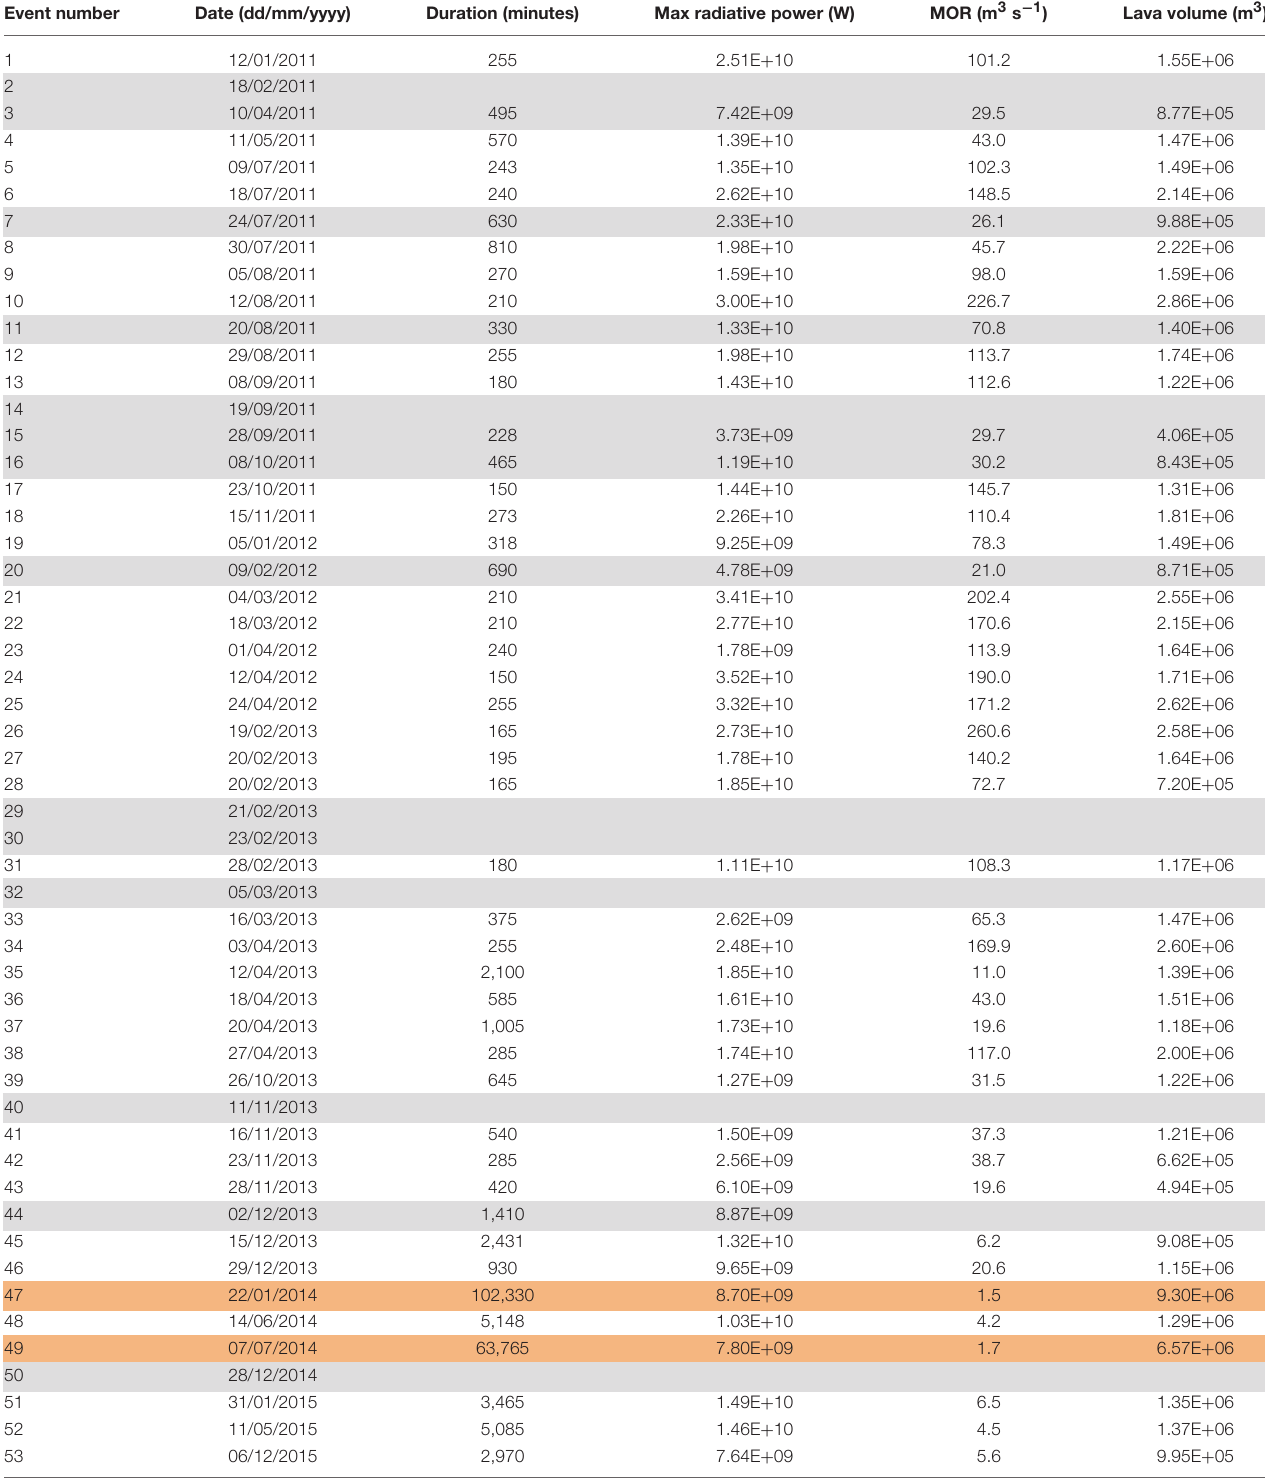
Gray filled rows highlight events affected by ash interference after fountaining and/or cloudy conditions. Orange filled rows refer to the two longest effusive periods.